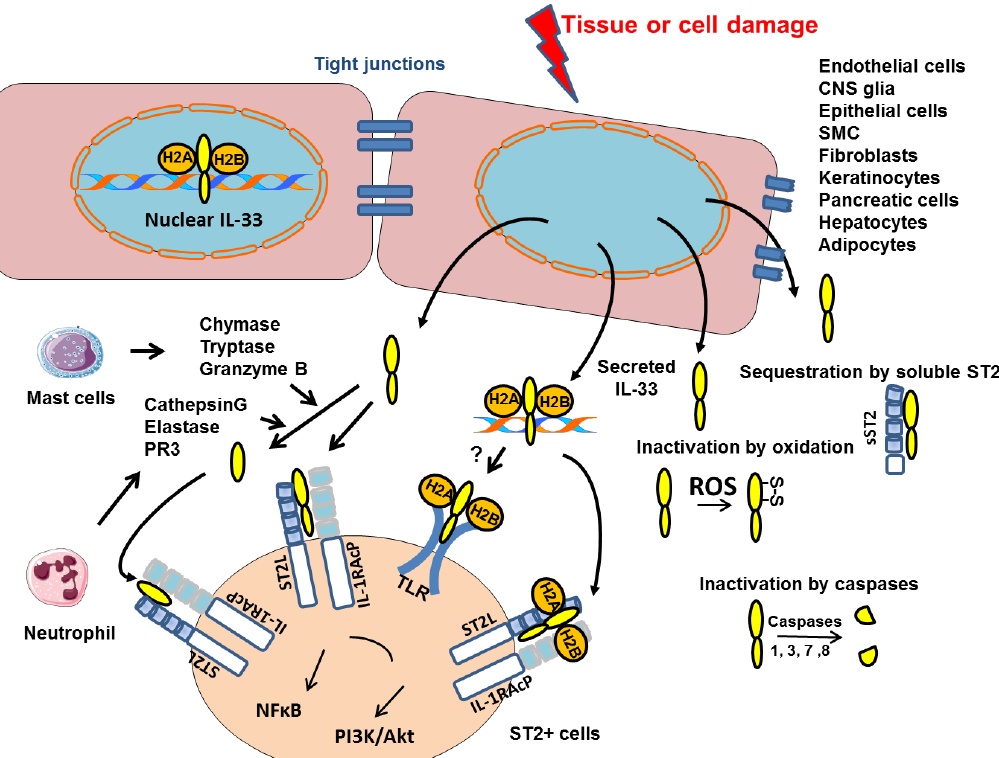
Figure 1. Mechanisms of intracellular IL-33 action and secretion. IL-33 is constitutively present in the nucleus of structural cells where it binds to chromatin by docking to the pockets of the histone H2A – H2B dimer. Upon cell or tissue damage, the IL-33 alarmin, is released extracellularly as a chromatin complex and is able to bind to receptors such as ST2 complexed to the coreceptor IL-1 receptor accessory protein (IL-1AcP) or supposedly TLR. IL-33 processing by inflammatory prote- ases produced by mast cells or neutrophils can generate mature forms with increased activity (up to 30-fold). Conversely, cleavage of the IL-1-like domain of IL-33 by caspases 1, 3, 7 or 8 could be an important mechanism of IL-33 inactivation during apoptosis. Extracellular IL-33 may also be se- questrated by soluble ST2 (sST2) or oxidized (formation of S-S disulfide bridges). All these inacti- vation mechanisms limit the range and duration of the ST2-dependent responses in